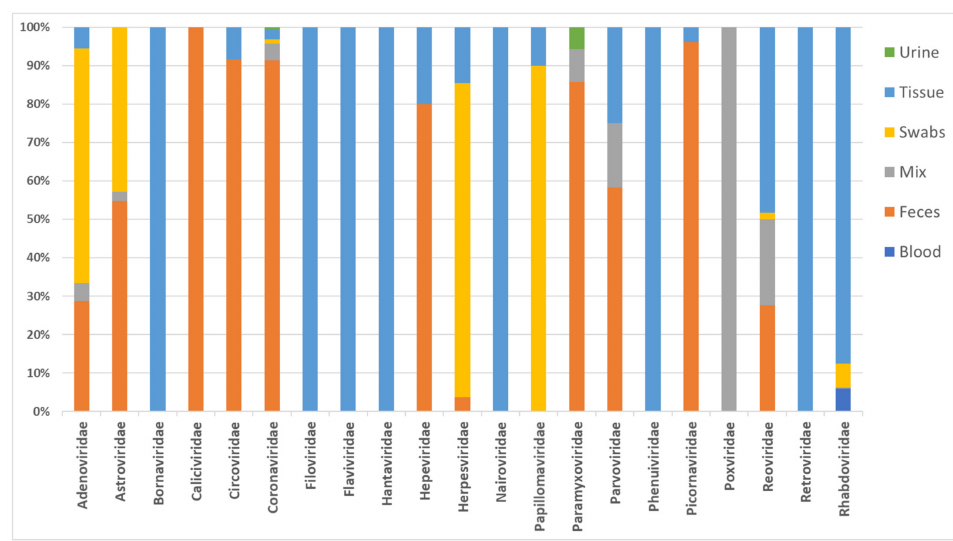
Figure 4. Specimen type used for virus detection related to the respective viral family and order (DBatVir [1]).